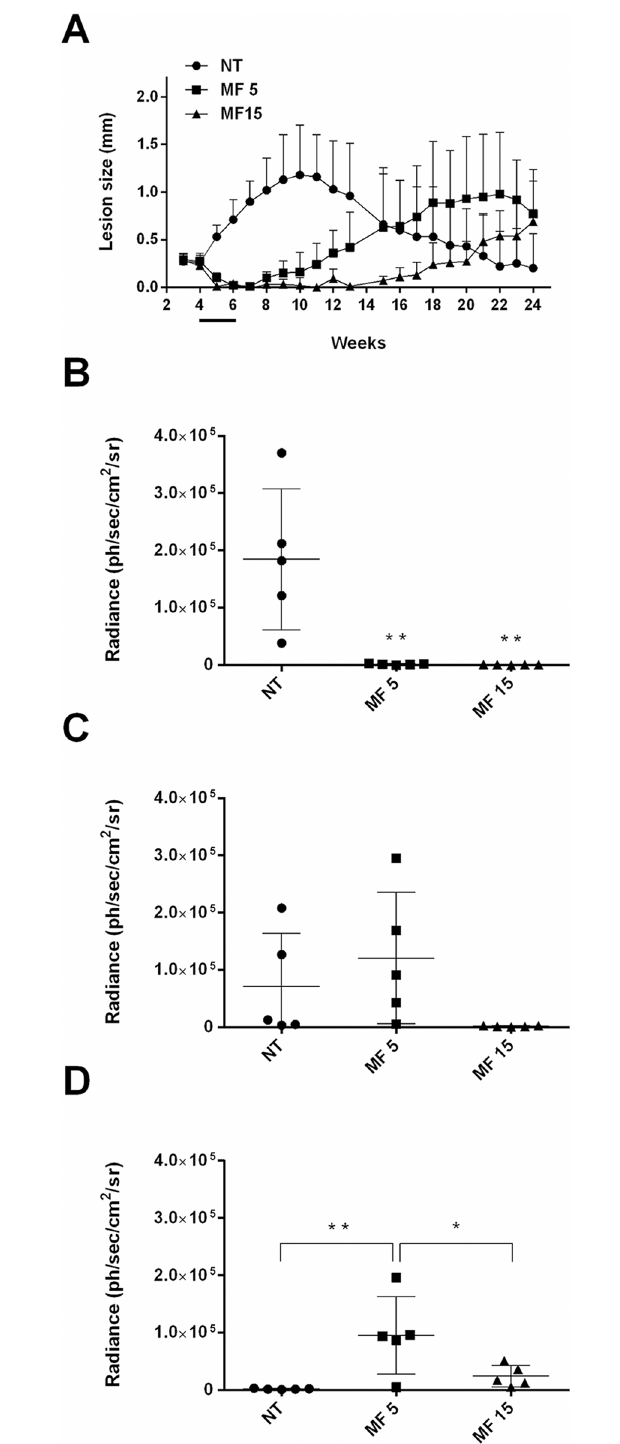
Fig 3. In vivo efficacy of miltefosine in a L . braziliensis -inoculated BALB/c mice model. 10 6 Lb -LUC stationary promastigotes were injected in the left hind footpad and animals were treated with 5 or 15 mg/kg/ day of miltefosine for 15 consecutive days (from to 4 th to the 6 th week post-inoculation). Average lesion size was measured weekly (five animals per group) in untreated and treated animals and horizontal black bar indicates MF treatment (A). Parasite burden was evaluated by bioluminescence at the end of the